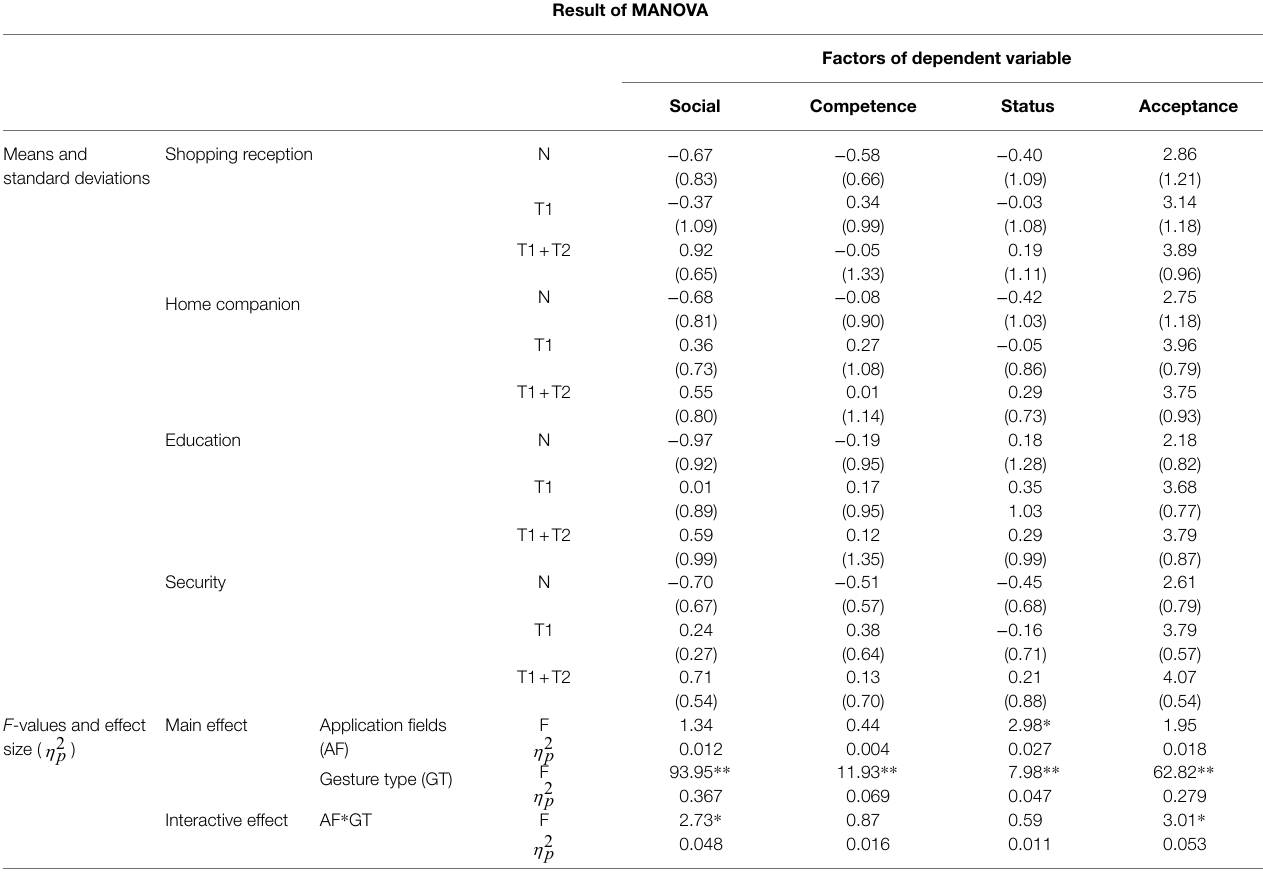
TABLE 4 | Results of